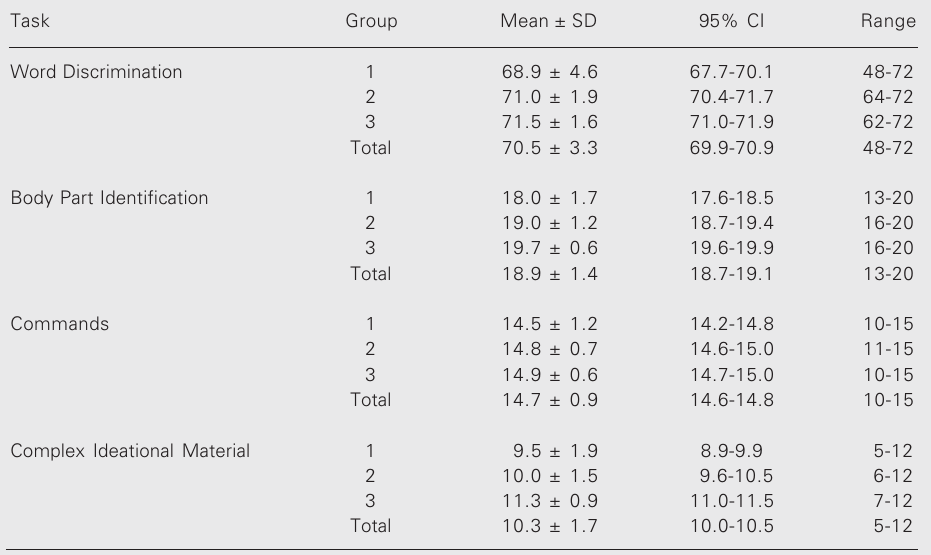
Table 3. Scores of subjects in oral comprehension tasks according to educational